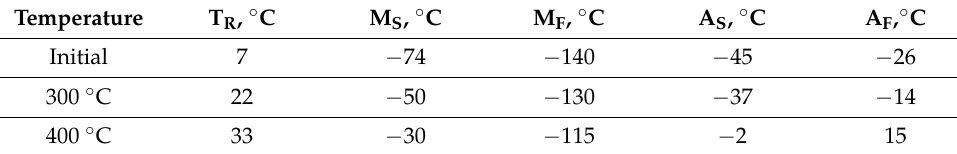
Table 1. Martensite transformation temperatures in nanocrystallineTi-50.9Ni alloy. Temperature T R , ◦